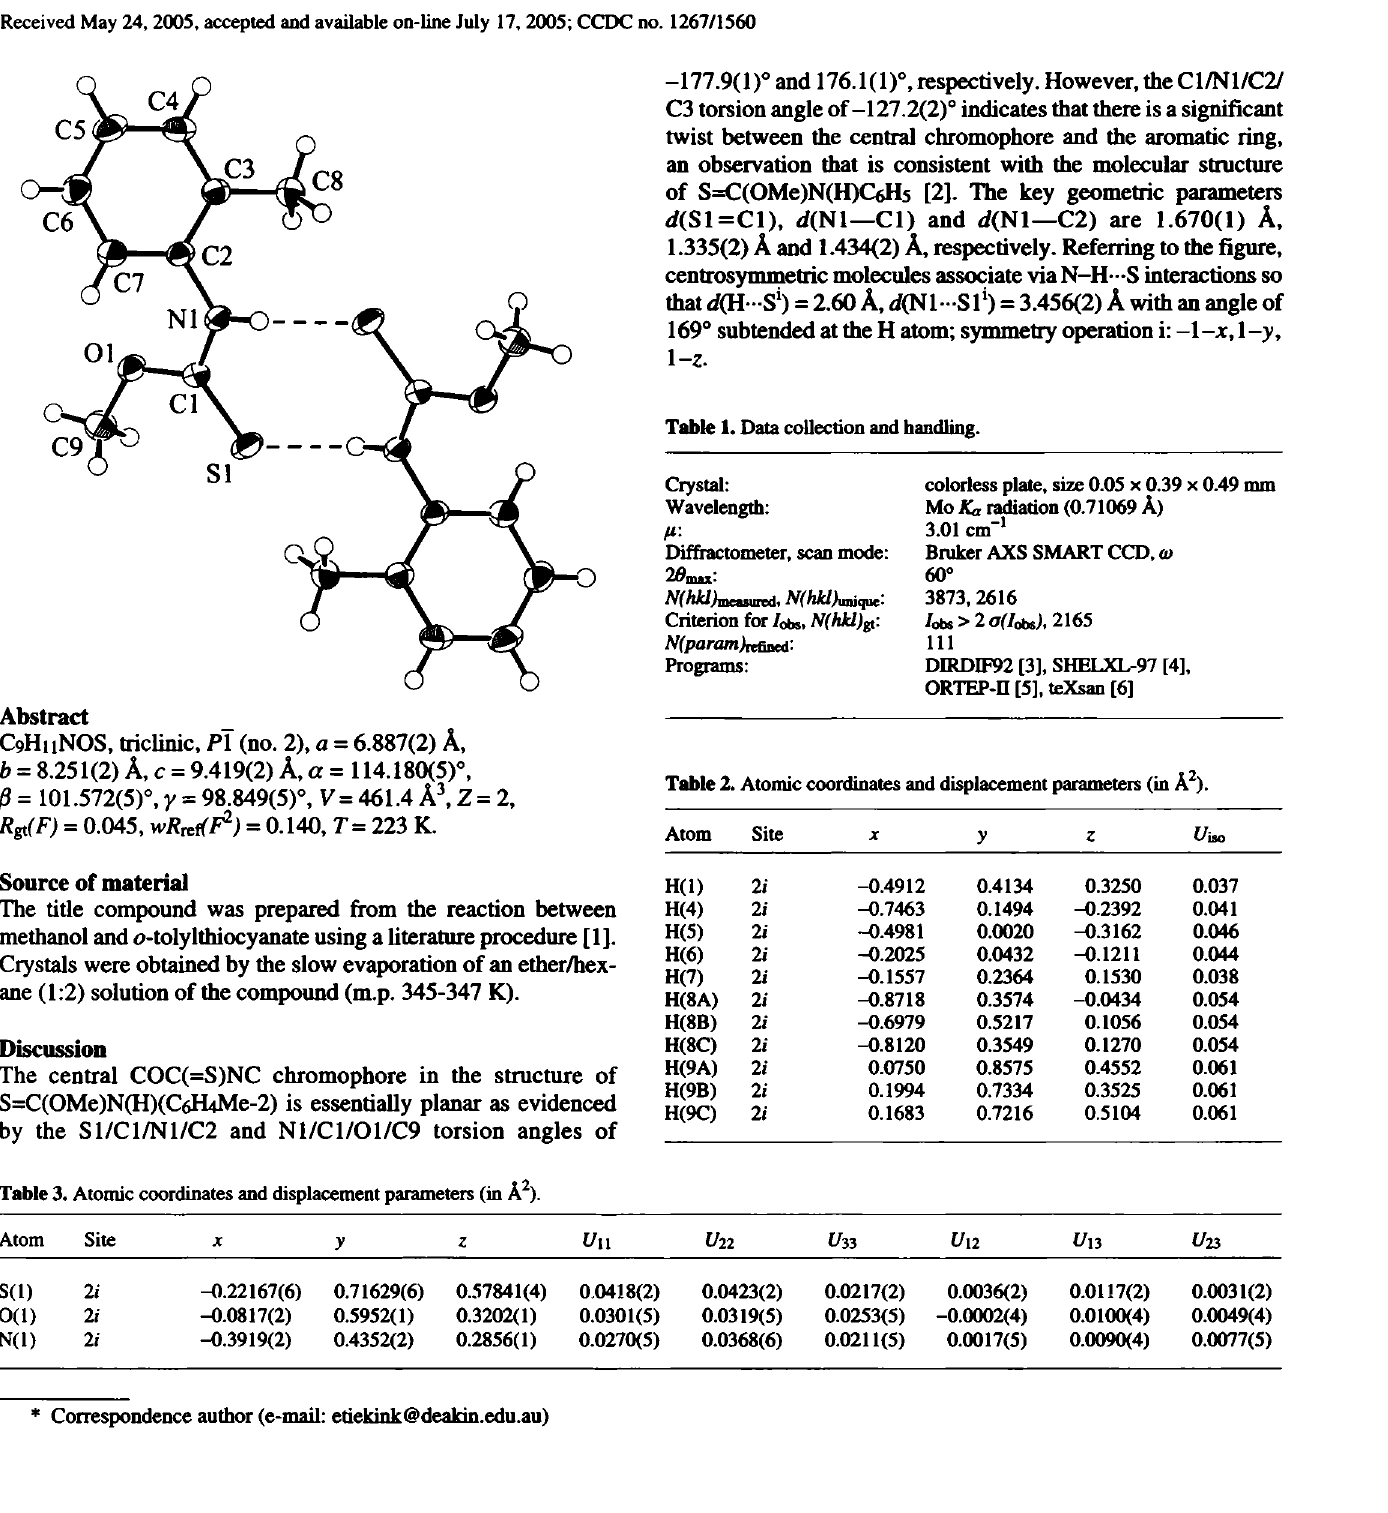
Table 3. Atomic coordinates and displacement parameters (in Ä 2 ).